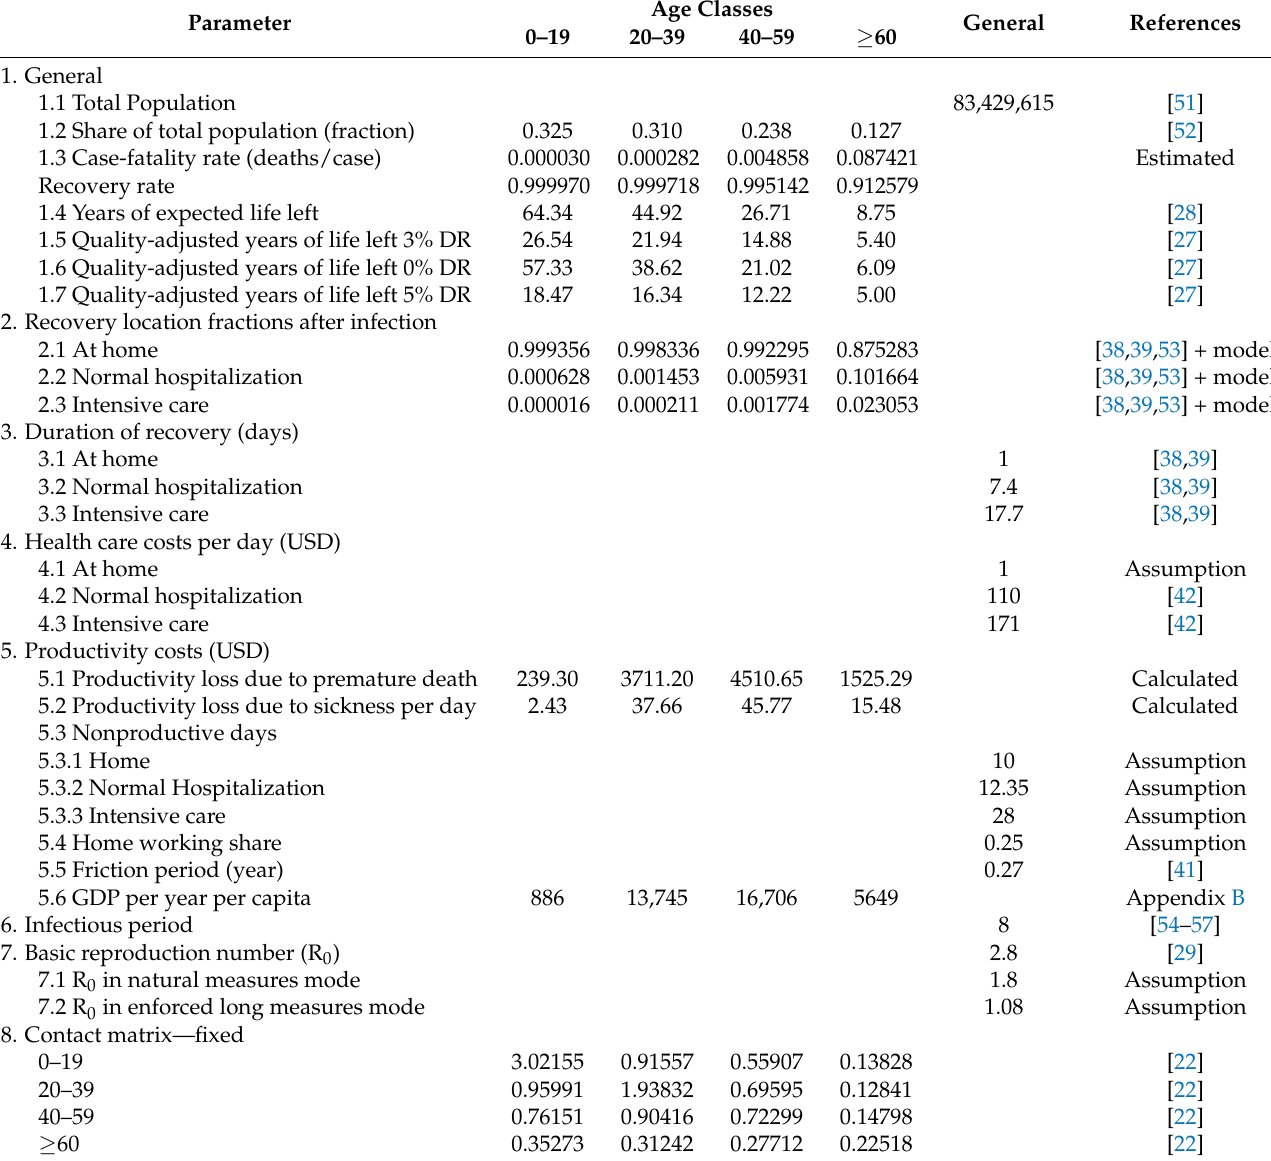
Table A1. Overview of the parameters used in the